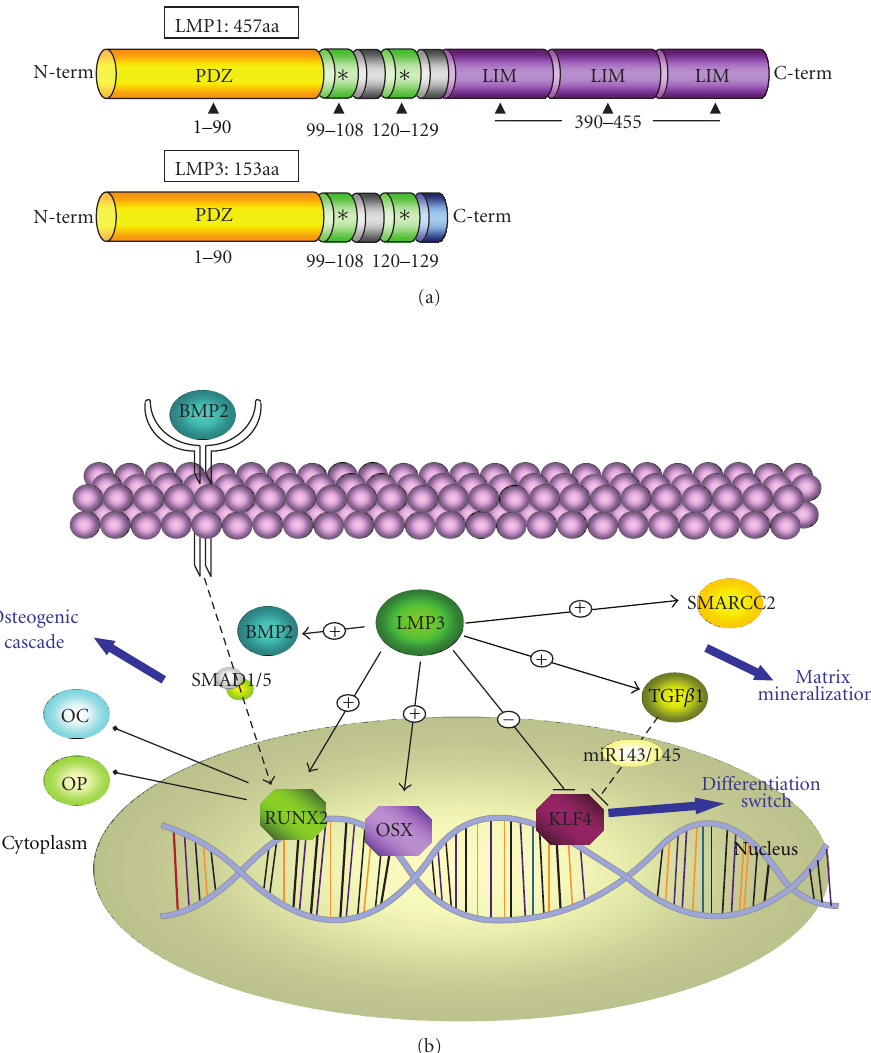
Figure 6: LMP domains and hypothetical signaling pathway.LMP1 and LMP3 are the osteogenic isoforms resulting from the alternative splicing of the PDLIM7 gene. (a) Both proteins share a conserved PDZ domain and a supposed osteogenic region which comprises two separate domains which interact with the SMURF1 WW2 domain (Sangadala et al, 2006). Three conserved LIM domains are present in the C-terminus of LMP1 while are absent in LMP3 due to its premature termination as a consequence of an out-of-frame insertion during splicing (see text for details). A scheme of the hypothetic molecular signaling induced by LMP3 in AFSC is proposed in (b) LMP3 induces the expression of the osteogenic transcription factors OSX and RUNX2, along with the osteogenic markers OC and OP. SMARCC2, involved in chromatin remodeling, is also a transcriptional target of LMP3, according to our results. LMP3 upregulates BMP2 that, on its turn, binds its surface receptor. This event induces the activating phosphorilation of SMADs that translocate to the nucleus to induce RUNX2, leading to the transcriptional induction of bone-specific genes mediating the osteogenic cascade. Conversely the KLF4 transcription factor is downregulated by LMP3. Also TGF β , induced by LMP3 in bone marrow-derived MSCs (Bernardini et al, 2010) represses KLF4 expression, by inducing the miR143-145 cluster (Davis-Dusenbery et al, 2011), which resulted una ff ected by LMP3 overexpression. A + sign inducate positive regulation, a – sign indicate negative regulation on the arrows and lines; EC: extracellular